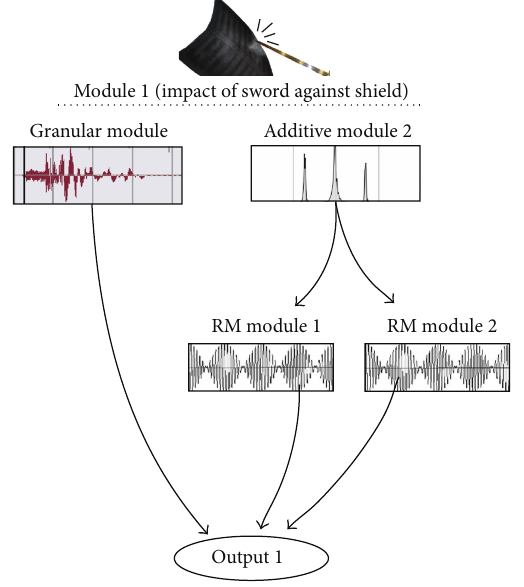
Figure 5: Illustration of the impact module 1 combining additive synthesis with granular and ring modulation for the sword against shield